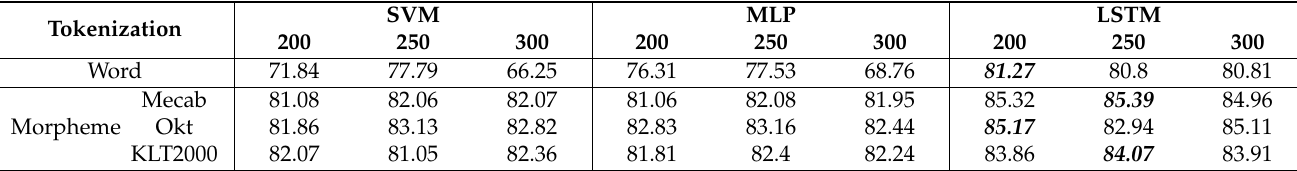
Table 3. Sentiment analysis accuracy with the sentence representation methods based on word and morpheme tokenization. Tokenization